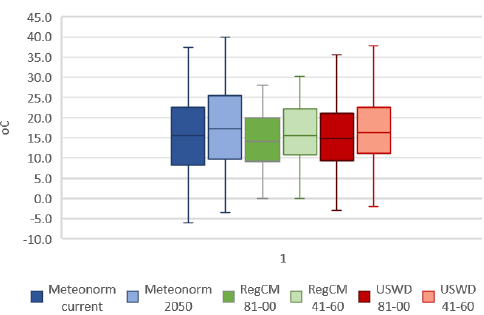
Figure 11. Boxplots of outdoor dry bulb temperature of all created weather datasets.